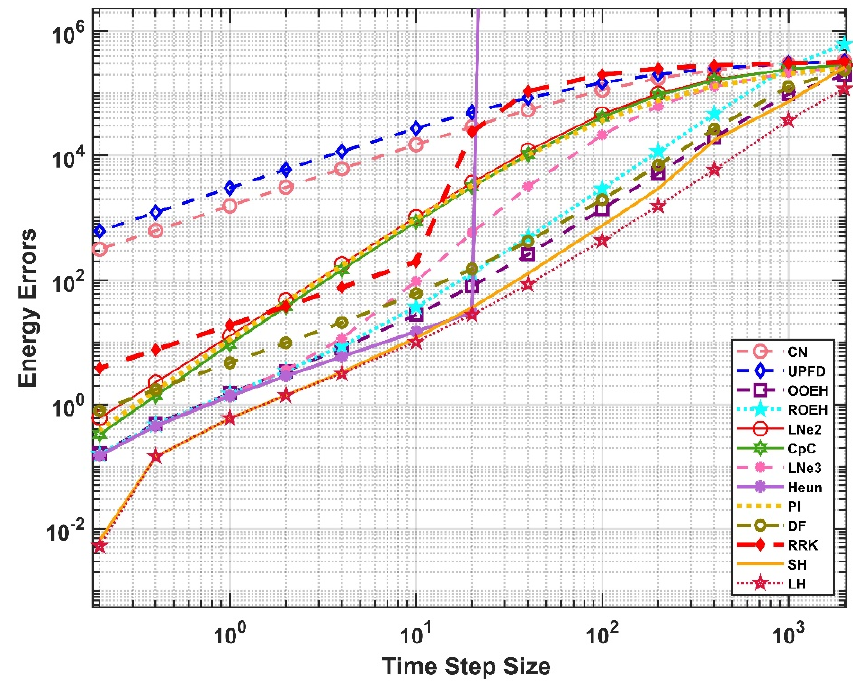
Δ for the non-equidistant mesh